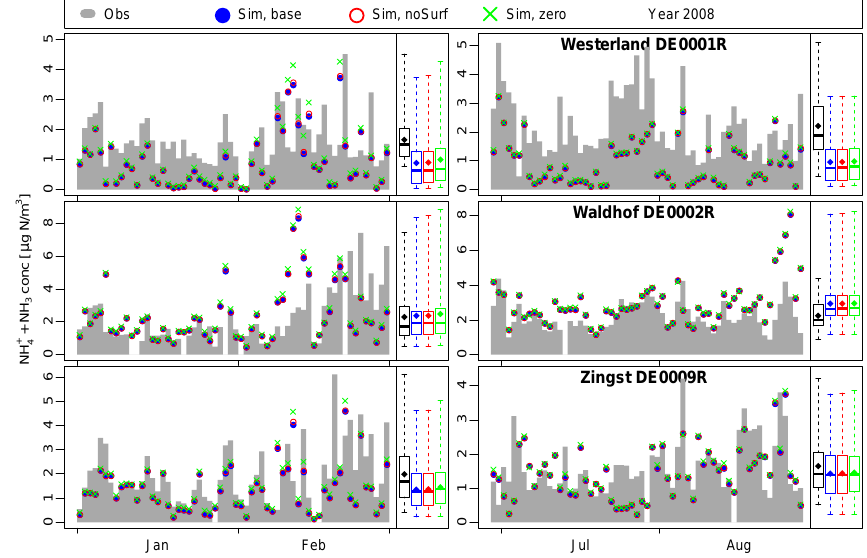
Figure 6. Similar to Fig. 5 but showing sNH 4 values of the base, noSurf, and zero sea salt emission